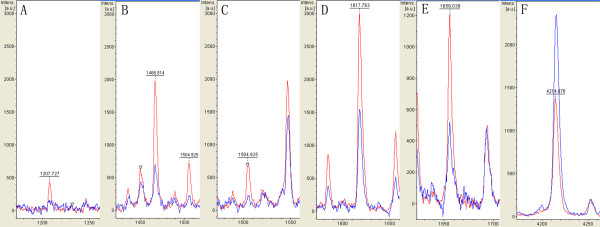
Zoom of the mass range for the six proteins (m/z 1208 (A), 1467 (B), 1505 (C), 1618 (D), 1656 (E) and 4215 (F), MALDI-TOF linear mode) used in the cluster to differentiate colorectal cancer (red) from healthy volunteers (blue).